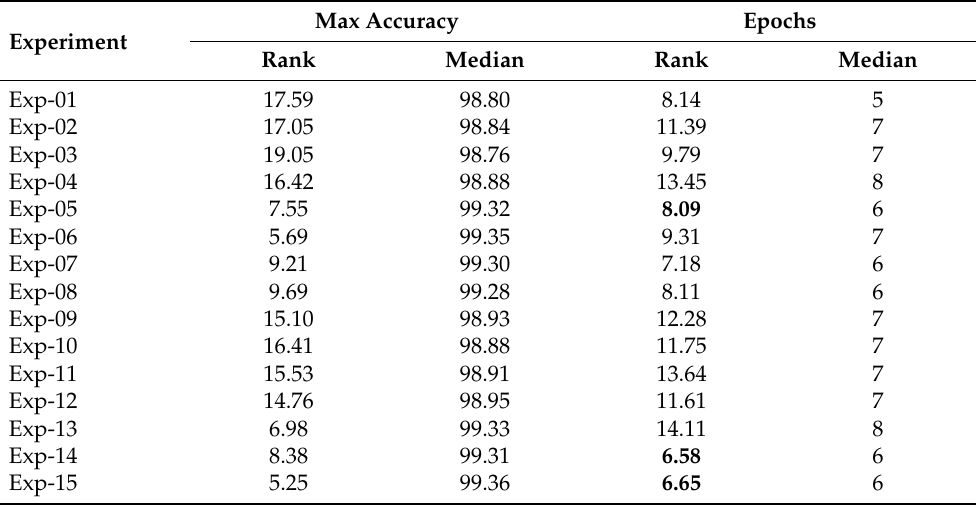
Table 13. Ranking of the maximum training accuracy and training epochs with medians by experi- ment. Best results are highlighted in bold. Max Accuracy Experiment